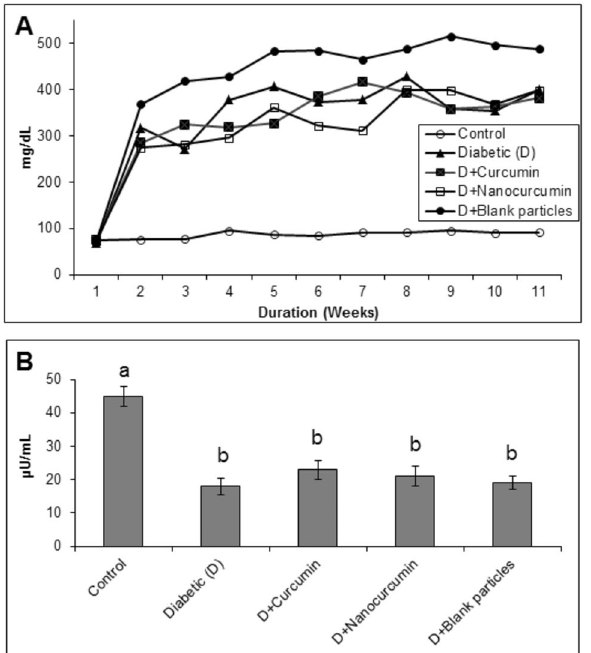
Figure 3. The effect of curcumin and nanocurcumin on blood glucose (Panel A) and insulin levels (Panel B) in STZ-treated rats. Data are average of all the animals in a given group. Different superscripts in Panel B indicate data are significantly different from other groups.